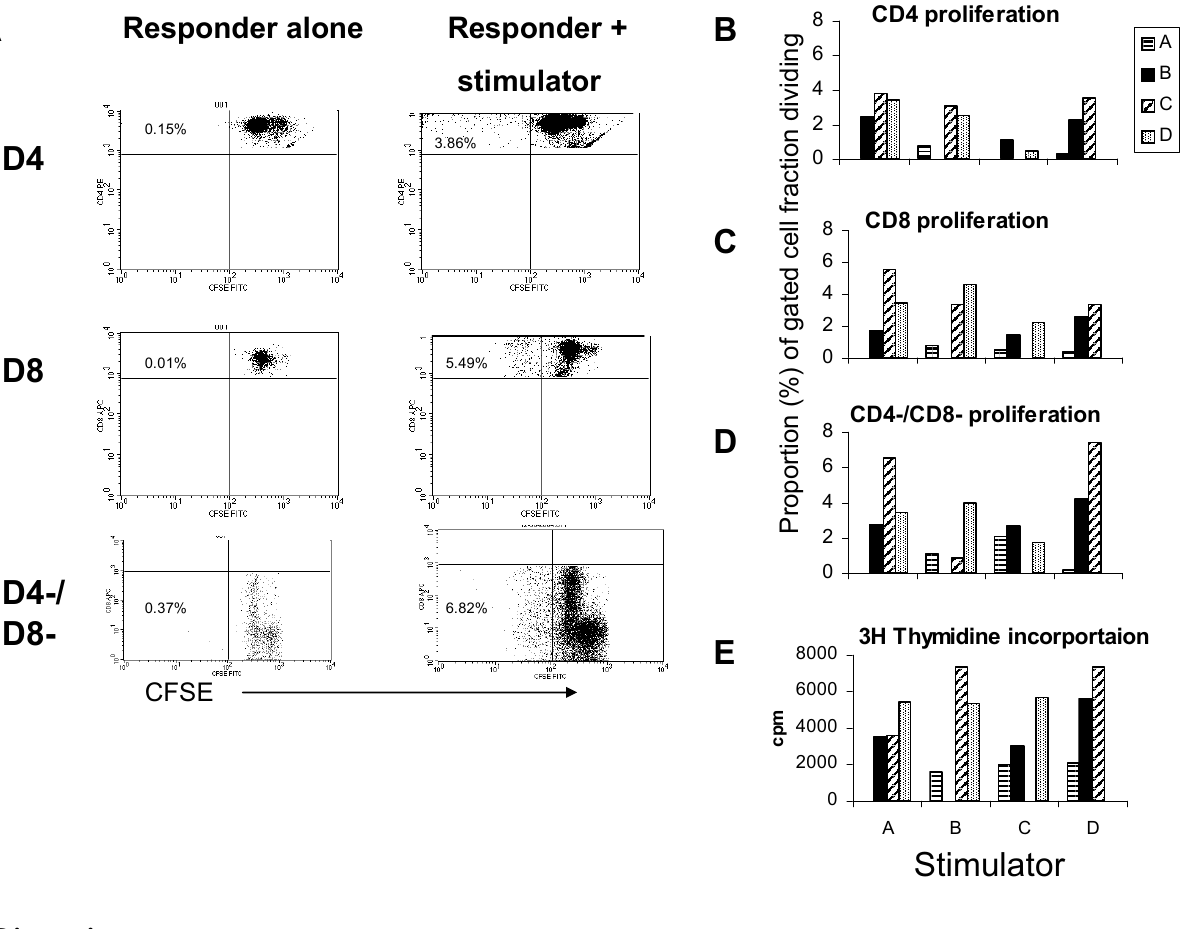
Figure 4. The allogeneic proliferative response entails a substantial non-T cell bystander component. Panel A. representative proliferative reaction by CFSE analysis. CFSE labeled allogeneic responder PBMC (300,000 cells/well) were cultured with CD3/56 depleted PBMC for 6 days. Lymphocyte gate was determined by forward and side scatter. CFSE dye dilution was analyzed on responder alone (left panels) vs. responder and stimulator (right panels) gating on CD4, CD8 and CD4-/CD8- cell fractions. Reactions for 4 separate stimulators (represented on x -axis) and responders (represented in legend) are shown in panels B–E , representing CD4 ( panel B ), CD8 ( panel C ), and CD4-/CD8- ( panel D ) proliferation by CFSE dye dilution analysis, or bulk proliferation by 3 H thymidine incorporation ( panel E